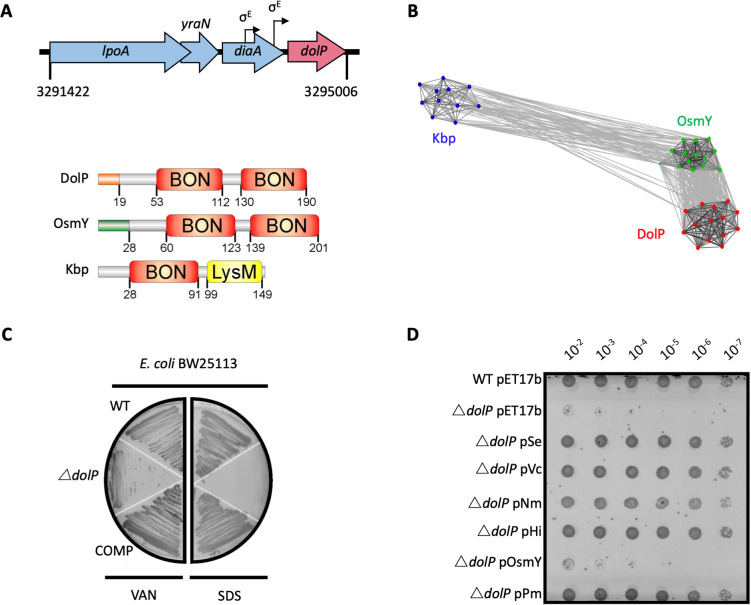
DolP is a conserved BON-domain protein with a distinct role in OM homeostasis.(A) In E. coli, dolP is located downstream of diaA and encodes a lipoprotein with a signal sequence (orange) and two BON domains (red). The signal sequence is cleaved by LspA, the cysteine at position 19 acylated by Lgt and Lnt and finally the protein is targeted to the OM by the Lol system (Figure 1—figure supplement 1). E. coli contains three BON-domain proteins. DolP shares a similar domain organisation with OsmY, which encodes a periplasmic protein that possesses a signal sequence (green) which is recognised and cleaved by the signal peptidase LepB. Kbp is more divergent from DolP and OsmY, has no predictable signal sequence and is composed of BON and LysM domains (Figure 1—figure supplement 2). (B) DolP, OsmY and Kbp are widespread amongst proteobacteria, and cluster into three distinct groups based on the program CLANS (Frickey and Lupas, 2004) with connections shown for a P value cut-off of <10−2 (Table 4). (C) Growth phenotypes for mutant isolates lacking DolP (ΔdolP), wild-type strain (WT) or the complemented mutant (COMP). Strains were grown on LB agar containing vancomycin (100 μg/ml) or sodium dodecyl sulphate (SDS; 4.8%). (D) DolP from diverse proteobacterial species expressed in an E. coli ΔdolP strain restores growth in the presence of vancomycin as assessed by a serial dilution plate growth assay. Plasmids expressing OsmY do not complement the defect.